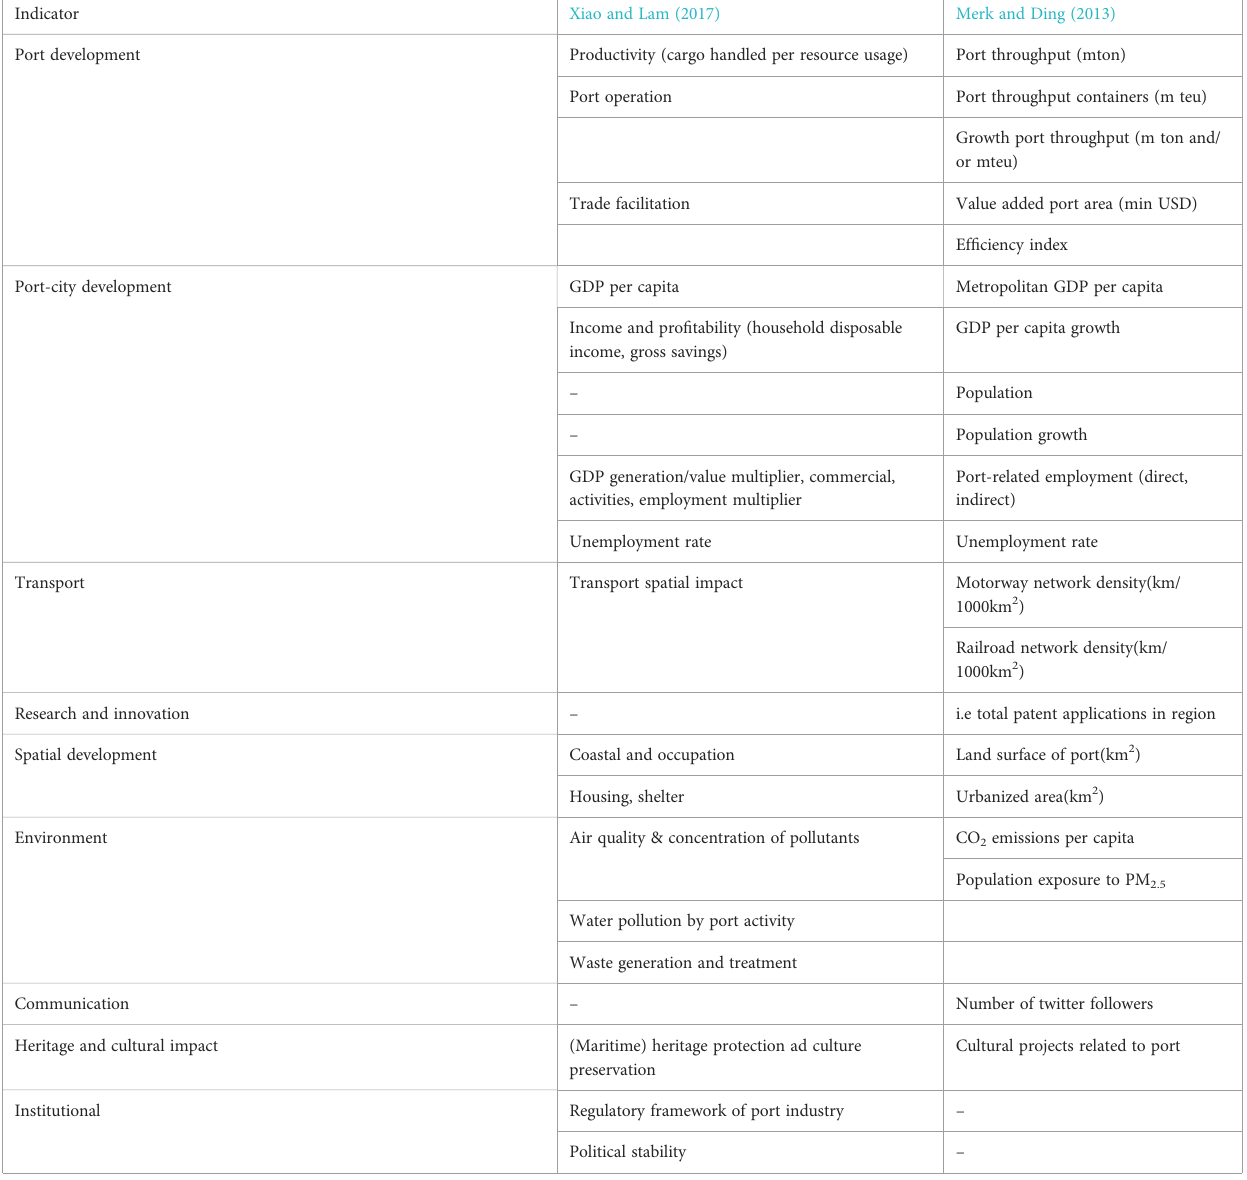
TABLE 1 Port-city performance indicators in